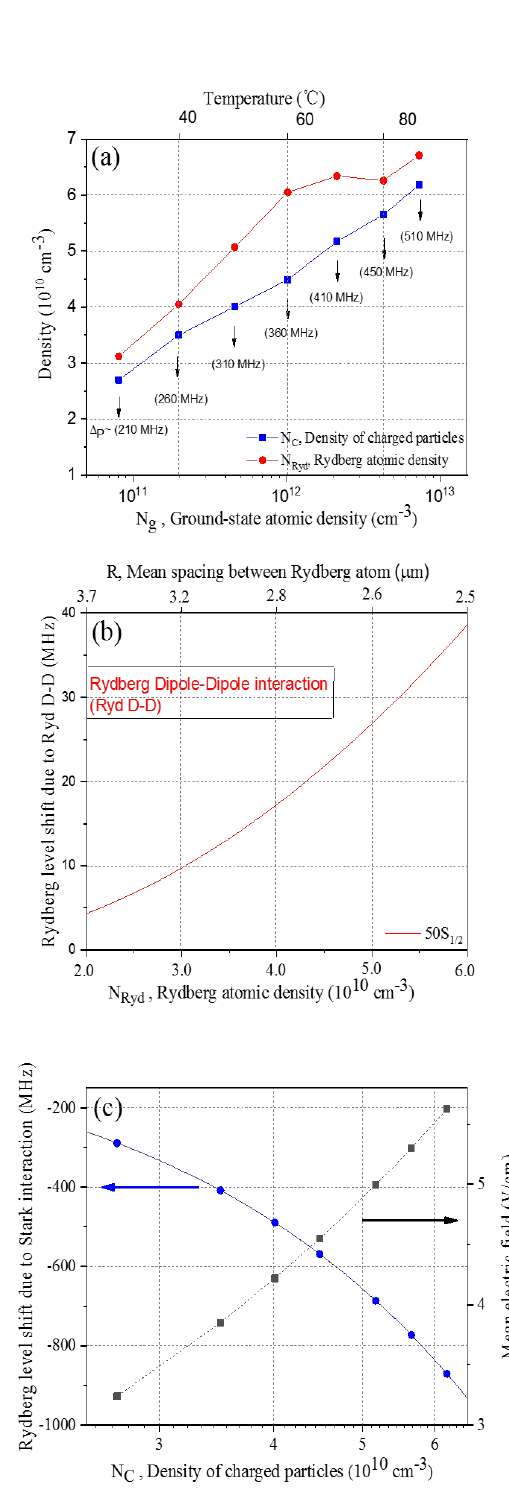
Figure 4. ( a ) The densities of charged particles and Cs 50S 1/2 Rydberg atoms. The blue squares indicate the densities of charged particles, while the red solid circles indicate Rydberg atomic densities; ( b ) Rydberg level shift due to Rydberg dipole–dipole interaction of Cs atoms for 50 S 1/2 state versus the calculated Rydberg atomic density; ( c ) Rydberg level shift versus N C for Cs 50 S 1/2 Rydberg state. The blue solid circles are Rydberg level shifts caused by the calculated density of charged particles, according to seven temperature conditions of Figure 3c, while the blue solid line shows Equation (3). The black squares indicate the mean electric fields based on the calculated density of charged